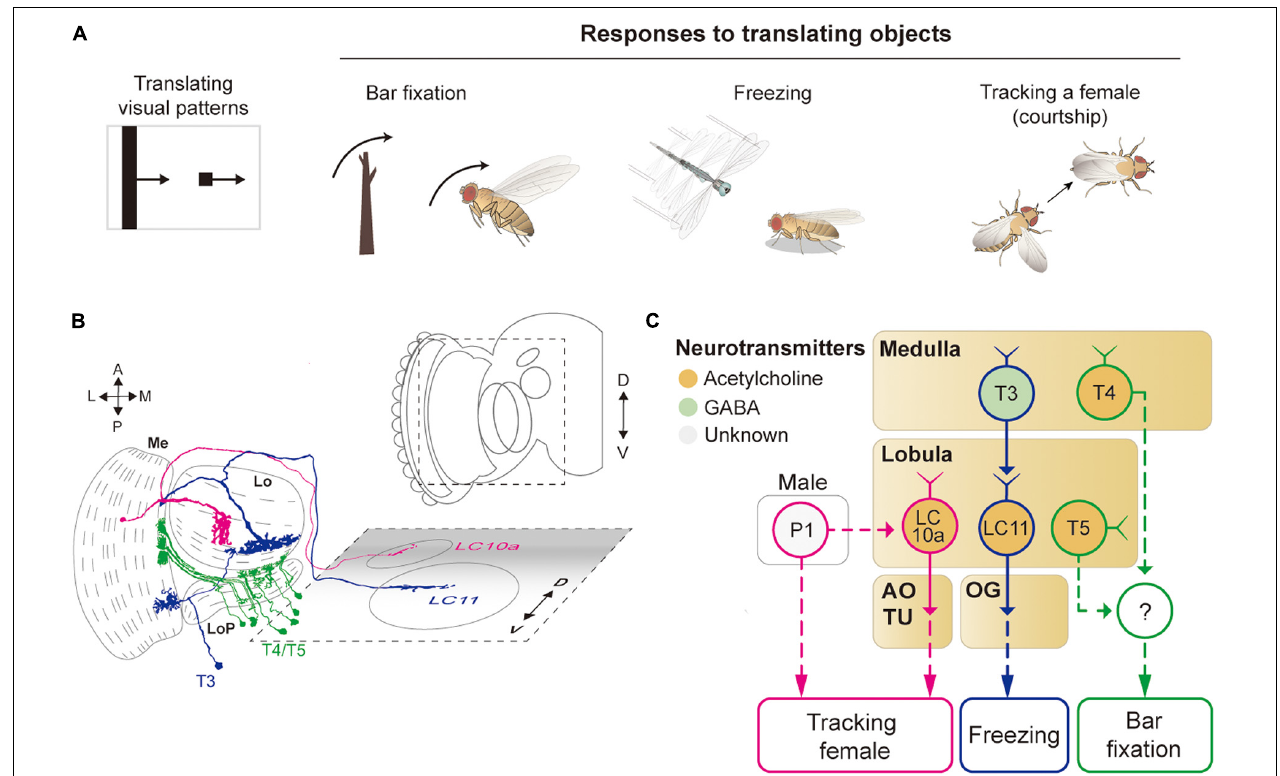
FIGURE 5 | Neural circuits underlying the detection of translating object for object-related behaviors. (A) Translating objects include a moving bar and a small spot (left pattern). Flying flies show robust attraction to a moving bar, whereas a moving spot causes freezing in walking flies and chasing by aroused males. (B) Schematic illustration of neurons related to the translating object-induced behavior. Graphical depiction is adapted from Fischbach and Dittrich (1989) and Wu et al. (2016). The colors of neurons match those in panel (C) . Me: medulla, LoP: lobula plate, Lo: lobula, OG: optic glomeruli, AOTU: anterior optic tubercle. (C) Schematic diagram of neural circuits related to the moving object-induced behaviors. Bar attraction is dependent on T4/T5 local motion detections (green outline). LC11 is highly selective to a moving, dark spot and is important for spot-induced freezing behavior (blue outline). LC10 mediates spot-induced chasing behavior in male flies when sexually aroused (pink outline). The face color of a circle represents the type of neurotransmitters released by a neuron, and the line color of a circle matches that of the neuron in panel (B) . OG: optic glomeruli, AOTU: anterior optic